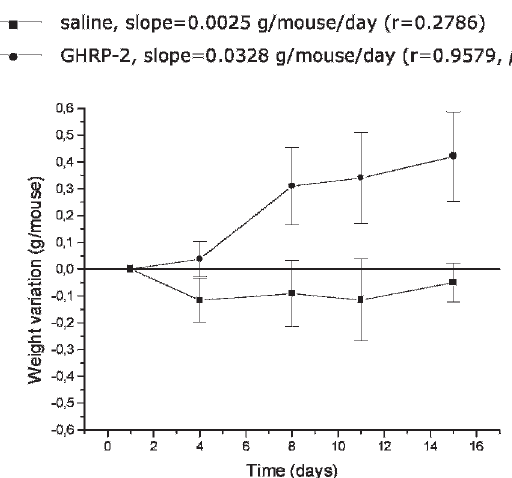
Figure 4 - The weight gain assay upon the chronic administration of 10 m g/animal/day GHRP-2 in the lit/lit mice; eight animals were used in this experiment (n=8). The control group was injected with saline; six lit/lit mice were used in this experiment (n=6). The mean and standard error of the mean intervals are